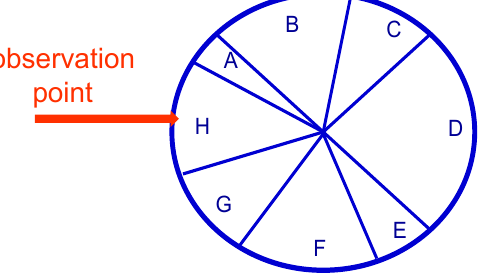
Figure 3. Random selection from biased roulette wheel.